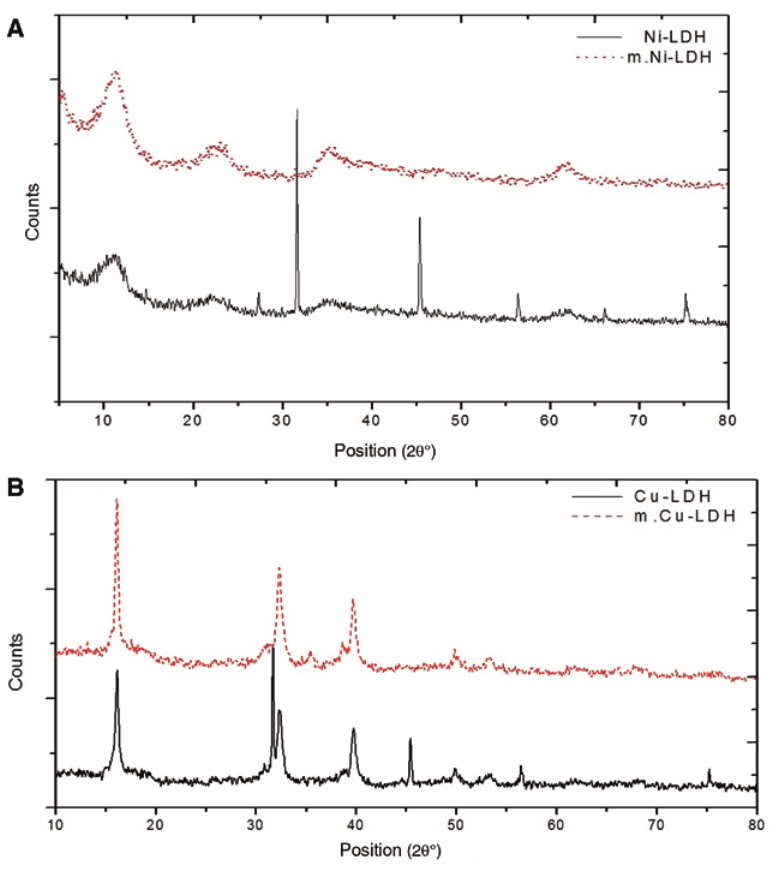
Figure 2: XRD patterns of (A) nanosized Ni-LDH and m.Ni-LDH and (B) Cu-LDH and